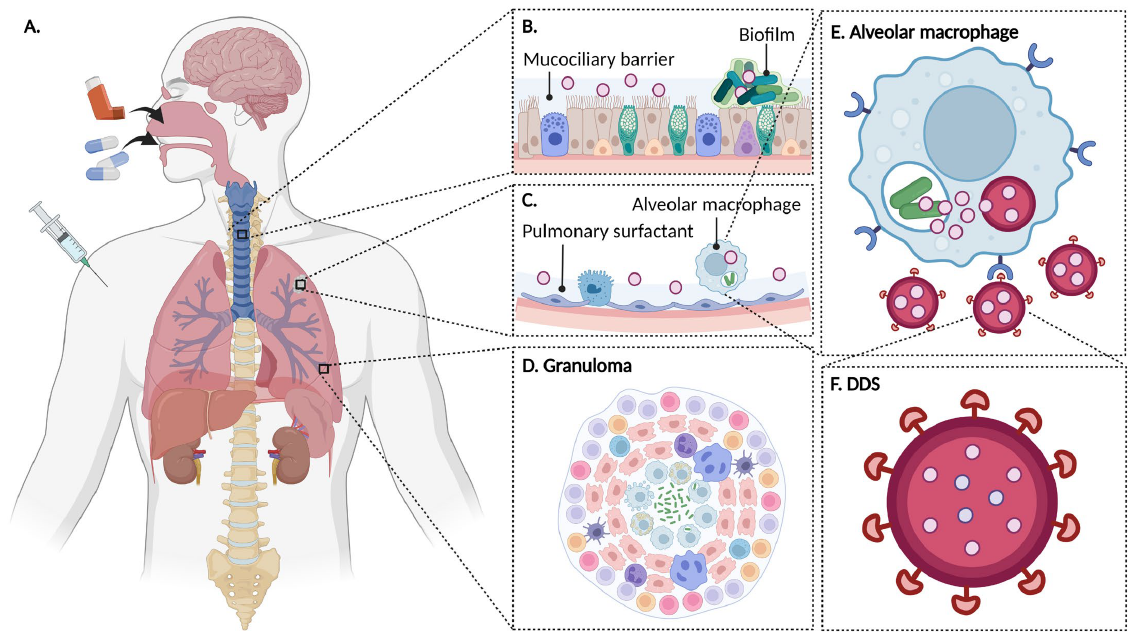
Figure 6. Use of nanosized drug delivery systems (DDSs) to fight tuberculosis. ( A ) Nanosized DDSs can be used to track Mycobacterium tuberculosis ( Mtb ) not only in the lungs (the site of infection in